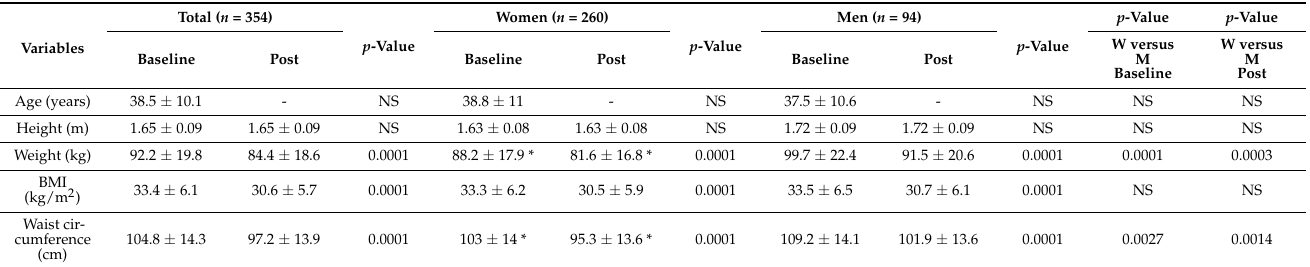
Table 1. Anthropometric (age) and physical characteristics (height, weight, BMI, and waist circumference), presented as the mean and standard deviation (X_±_SD) of total participants and separated by sex (women and men) before (baseline) and after 5 weeks of application of the 4 Phases Methodology (post).